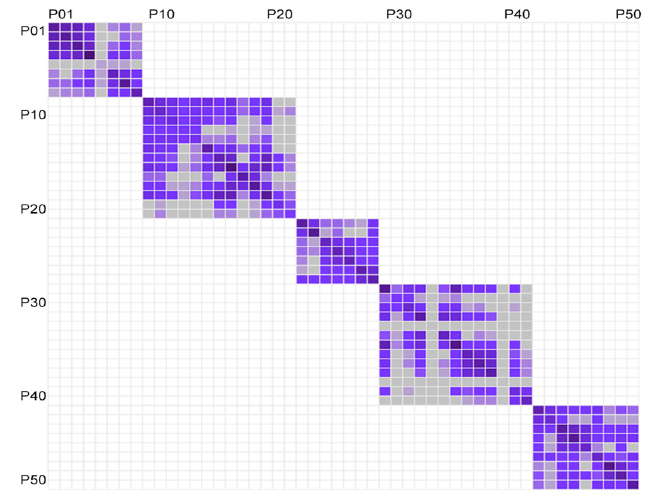
Figure 5. Netgraph showing inter-unit contact pairs in the five study units.